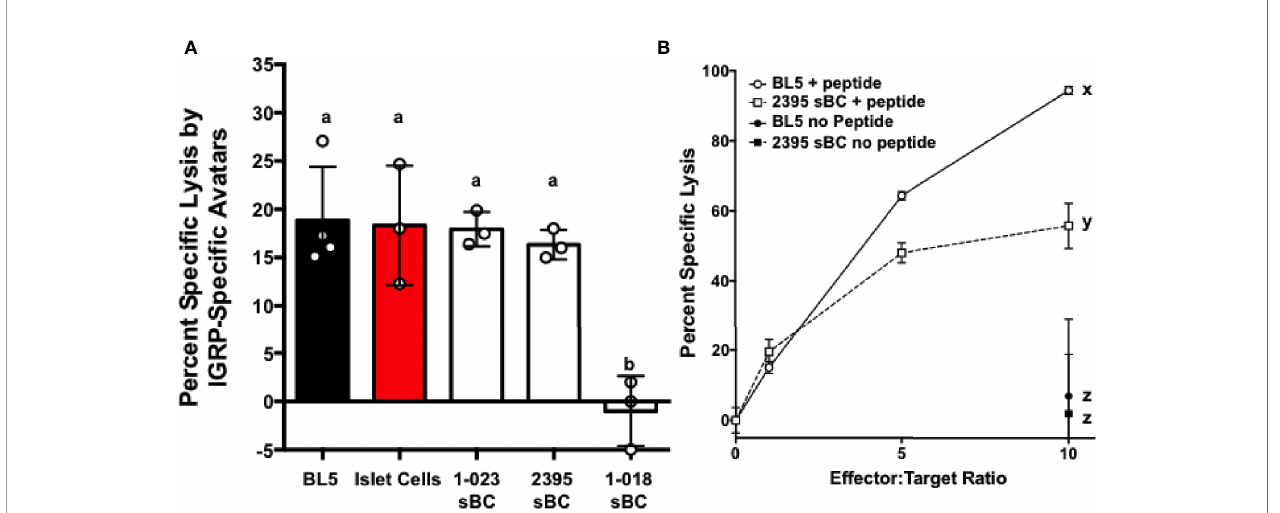
FIGURE 6 | sBC are ef fi ciently targeted by donor 2395 CD8 + T cell avatars in an antigen speci fi c and HLA restricted manner. (A) Donor 2395 IGPR T cell avatars were co-cultured with b L5 cells, primary islet cells from a HLA-A*0201 positive donor, 1-023 sBC, or 2395 sBC the cells were effectively lysed at an effector to target (E:T) ratio of 10:1. As 1-018 sBC do not harbor HLA-A*0201 these cells were not lysed by these T cell avatars as they require the IGRP peptide to be presented by HLA-A*0201. (B) Donor 2395 MART-1-avatars were co-cultured with either b L5 cells or donor 2395 sBC at increasing E:T ratios (0:1, 1:1, 5:1, and 10:1). When pulsed with Melan-A 26-35 , lysis of both b L5 and 2395 sBC increased with escalating E:T ratios. In the absence of Melan-A 26-35 , no lysis was measured. *Letters denote signi fi cance: groups/lines with different letters were statistically signi fi cant (P<0.05), whereas those with the same letter were not statistically different. These data are from at least 3 independent studies performed in